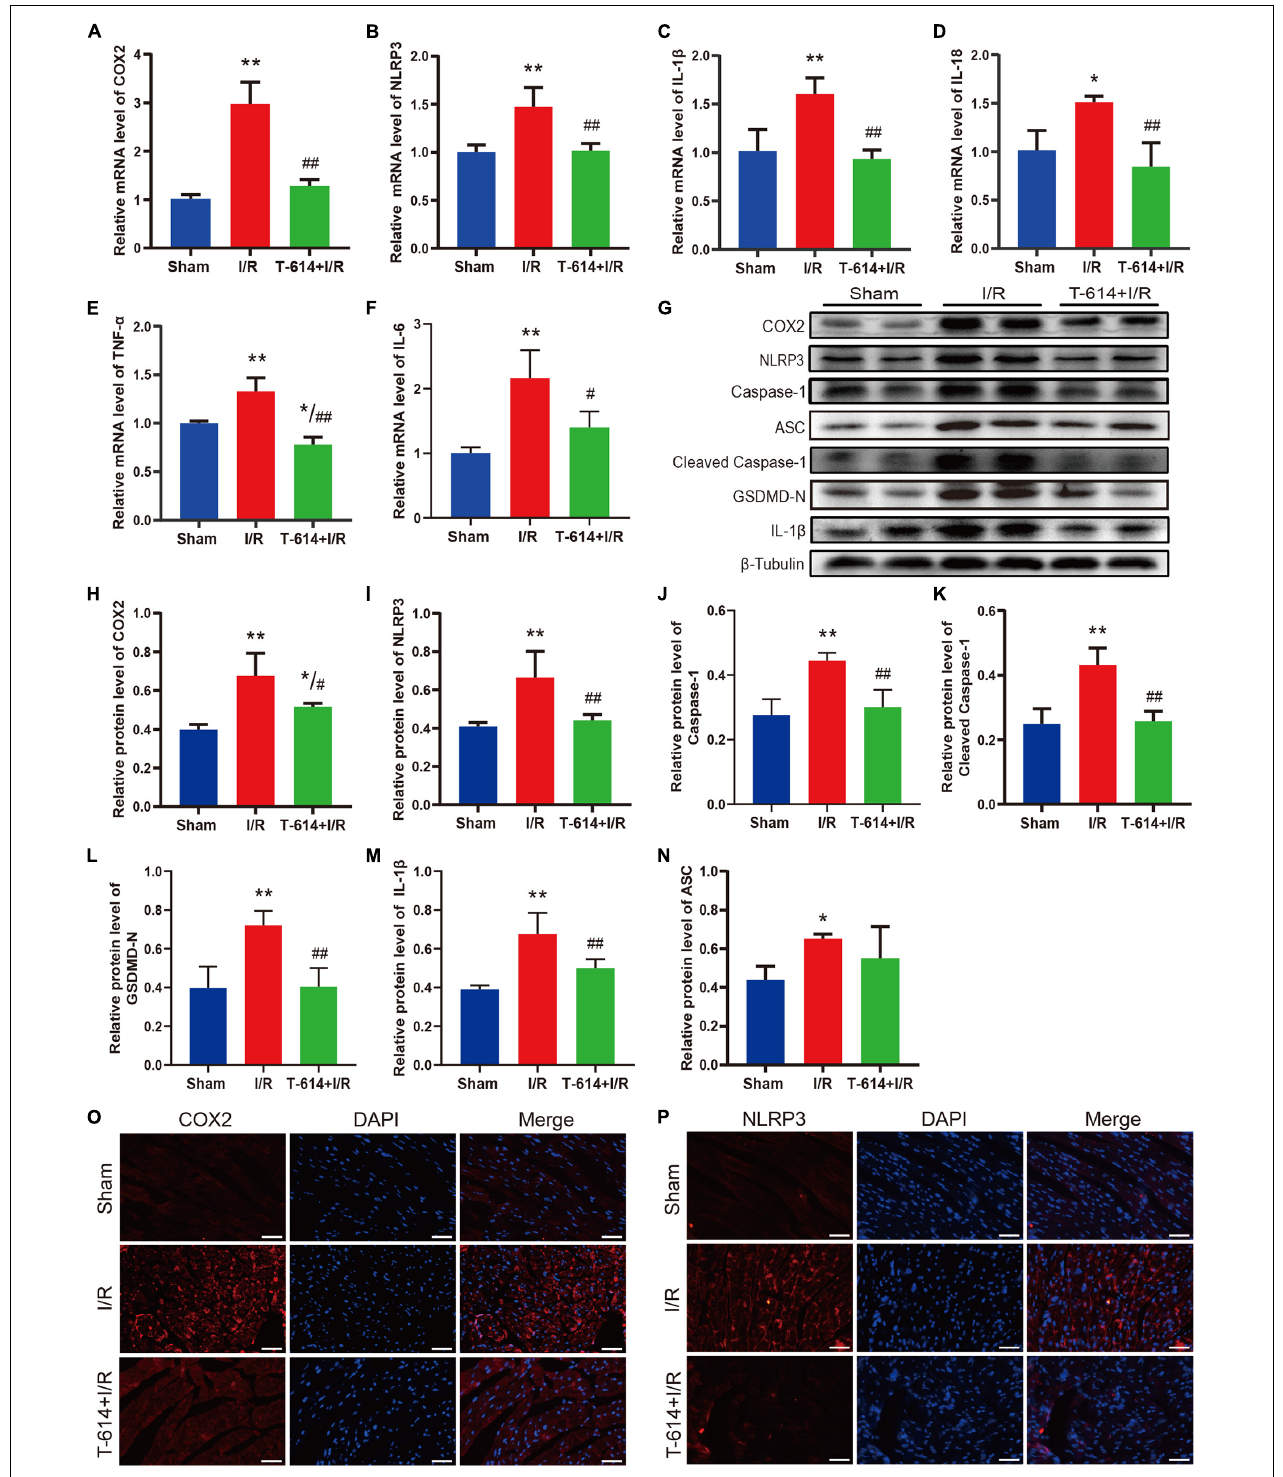
FIGURE 5 | Pyroptosis and inflammatory response mediated by COX2/NLRP3 signaling pathway were suppressed by iguratimod. (A–F) Relative mRNA expression levels of COX2, NLRP3, IL-1 β , IL-18, IL-6, and TNF- α among Sham, I/R and T-614 + I/R group. n = 4. (G) Representative Western blotting luminogram of COX2, NLRP3, caspase-1, ASC, cleaved caspase-1, GSDMD-N, and IL-1 β of the three groups. (H–N) Protein semiquantification standardized by β -Tubulin. n = 5. (O,P) Representative immunofluorescence staining pictures of COX2 and NLRP3 in left ventricular myocardium from hearts of different mice. Scale bar = 50 µ m. Data are expressed as mean ± SD;* p < 0.05, ** p < 0.01 versus Sham group; # p < 0.05, ## p < 0.01 versus I/R group. I/R, ischemia/reperfusion.